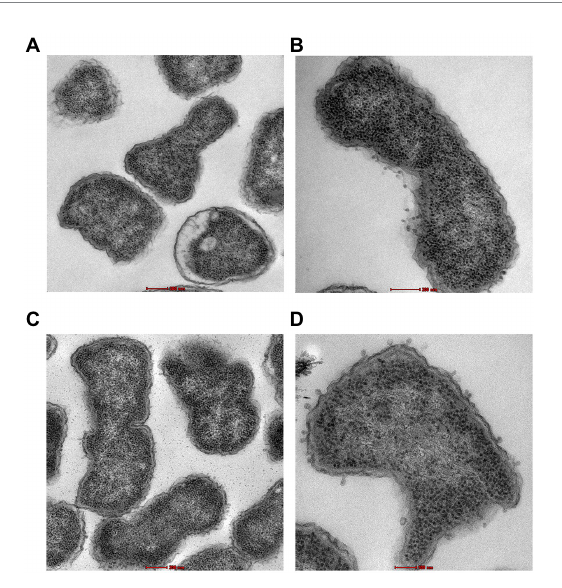
FIGURE 5 Morphological changes in the bacterial cells ( E. coli strain EC26) treated with PMBN alone (A, B) and PMBN with AZT (C, D) observed using transmission electron